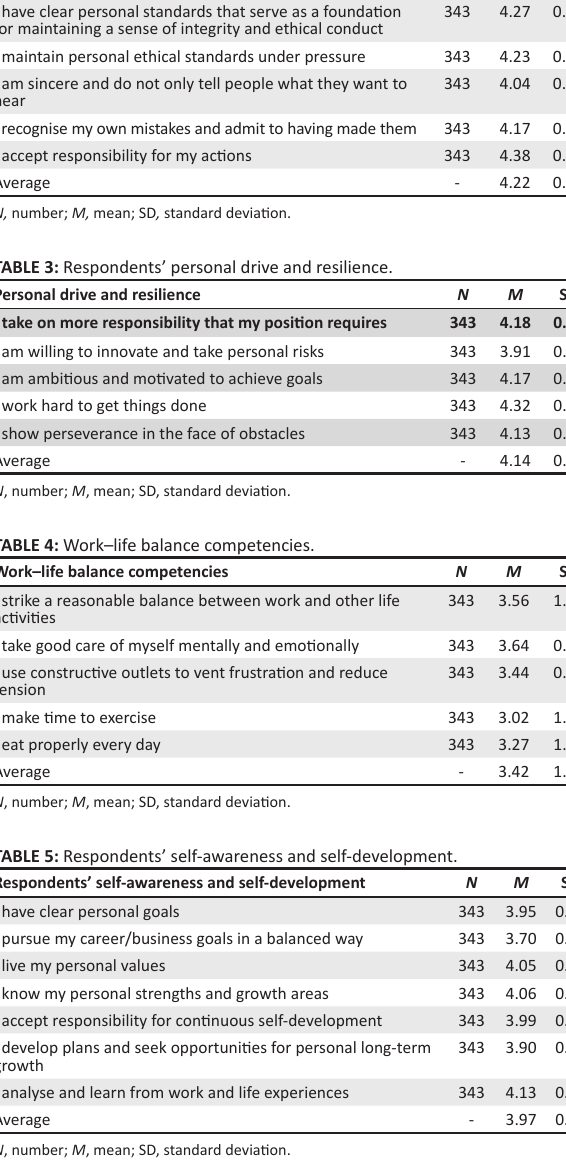
TABLE 2: Respondents’ integrity and ethical conduct. Respondents’ integrity and ethical conduct